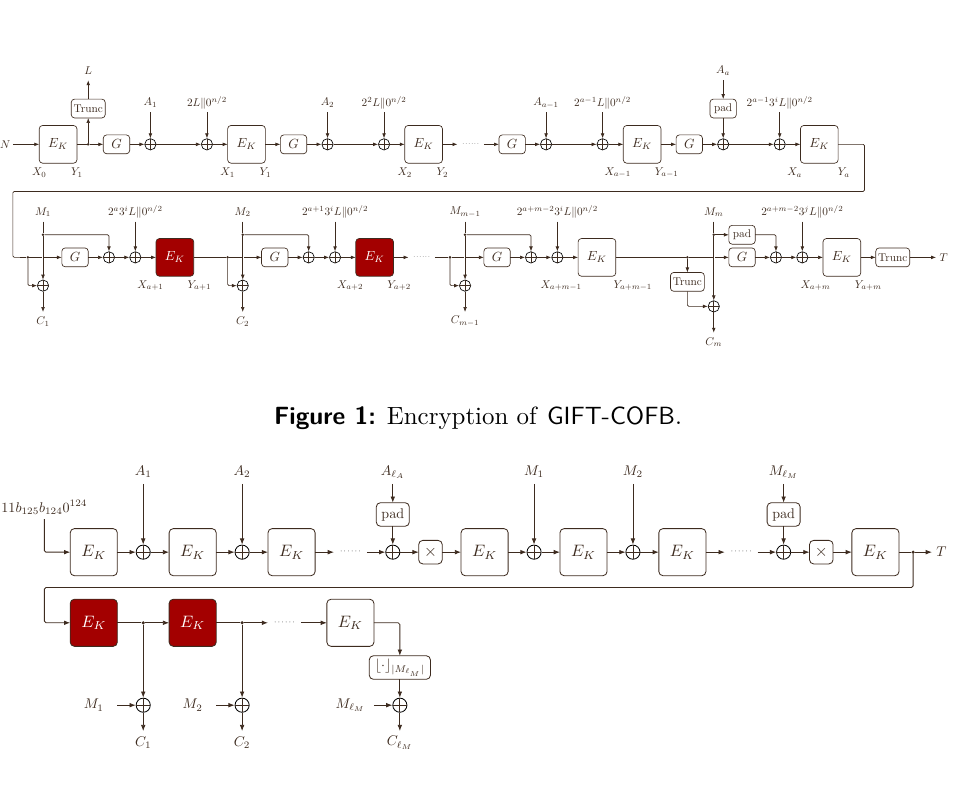
Figure 2: Encryption of SUNDAE-GIFT